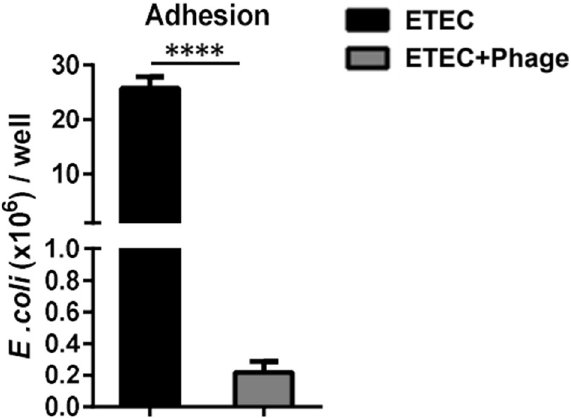
Figure 3. Phage EK99P-1 inhibited the adhesion of ETEC K99 to IPEC-J2. Differentiated IPEC-J2 was treated with ETEC K99 (1 × 10 7 cfu/mL) and phage EK99P-1 (1 × 10 6 pfu/mL) for 24 h. An E. coli adhesion assay was performed on IPEC-J2 (n = 3). Data are means ± SD. Means were compared using a two-tailed Student’s t -test. **** P < 0.0001 compared to the ETEC control.